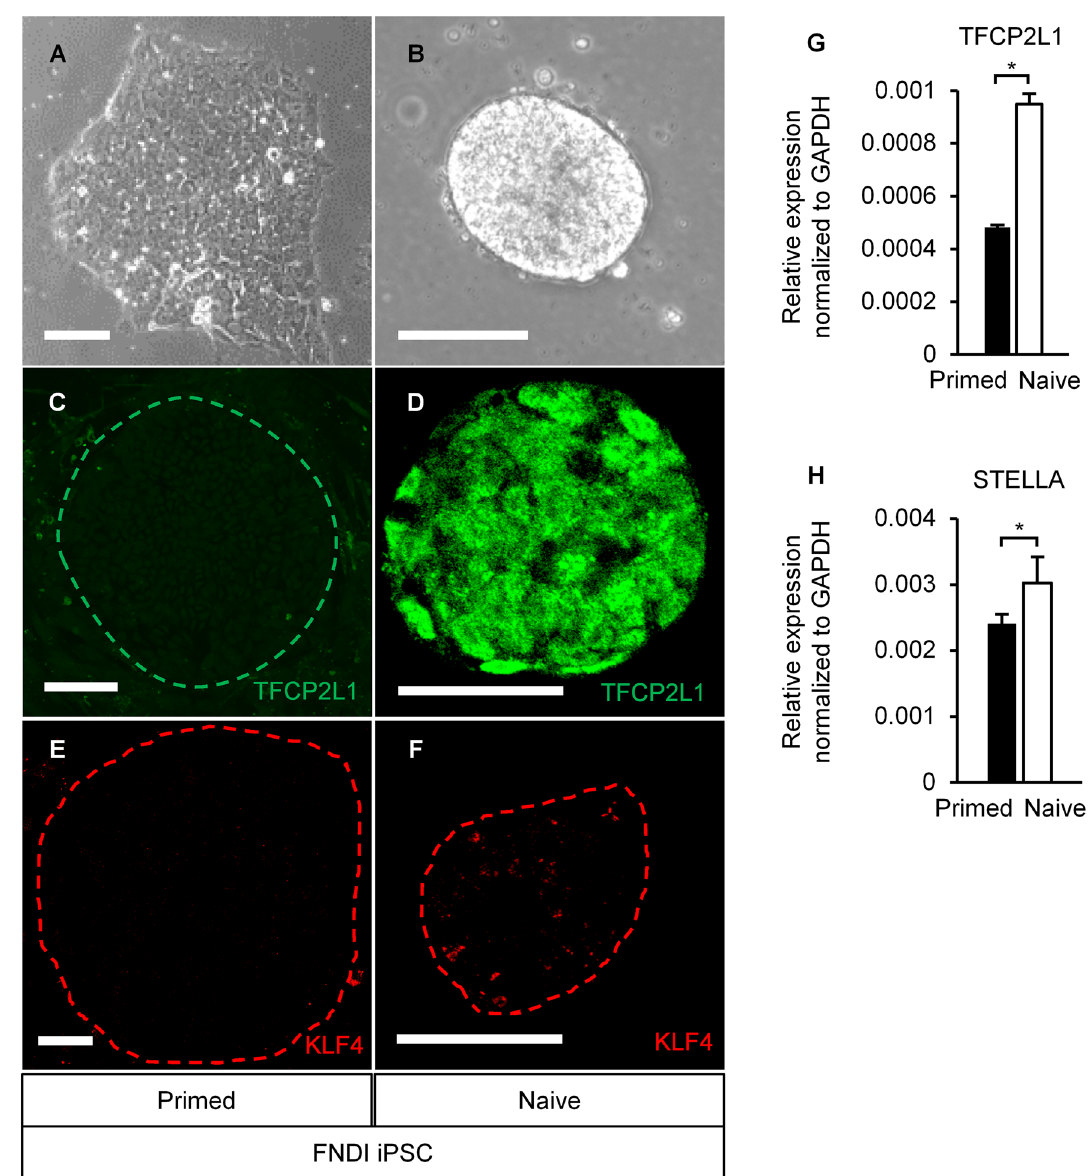
Figure 1. Conversion of primed hiPSCs by the naive conversion kit. ( A ) Primed hiPSC colonies had a flat morphology. Conversion by the naive conversion kit changed the morphology of colonies to tightly packed and domed ( B ), and TFCP2L1 (green) ( C,D ) and TLF4 (red) ( E,F ), naive markers, were expressed on P9. ( G,H ) Mean ± SEM. *P < 0.05, two-tailed unpaired t -test. The naive marker’s difference before and after conversion, TFCP2L1 and STELLA, was confirmed by RT-qPCR on P3, 4, and 5. FNDI-disease specific human iPSCs (FDI- 02). Scale bars, ( A,B ) 100 µm, ( C–F ) 50